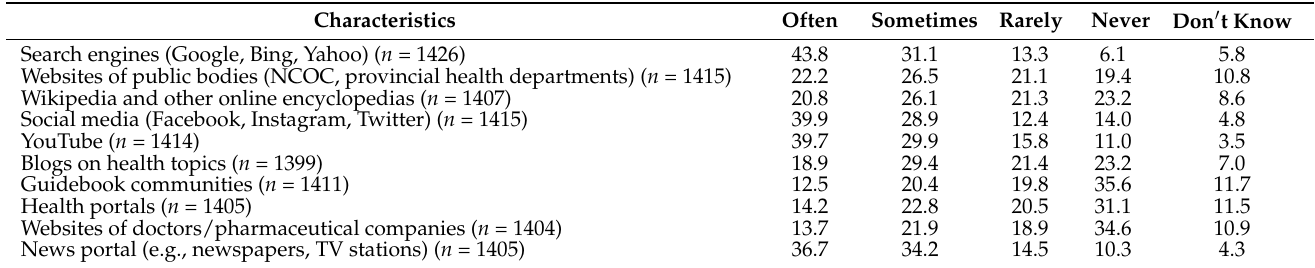
Table 4. Searching for information related to COVID-19 and related topics on the